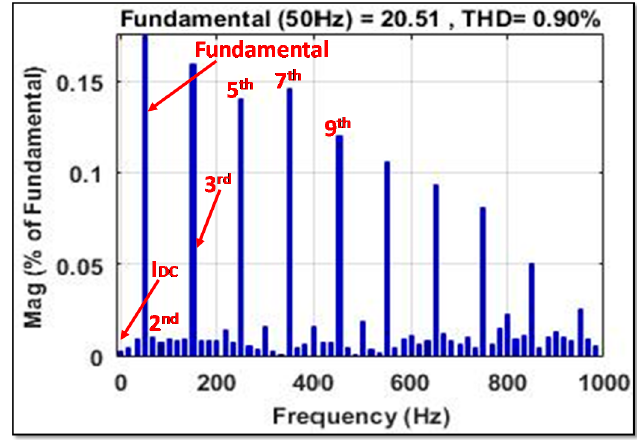
Figure 20. Harmonic content of the grid current in charging mode for Unipolar Modulation.